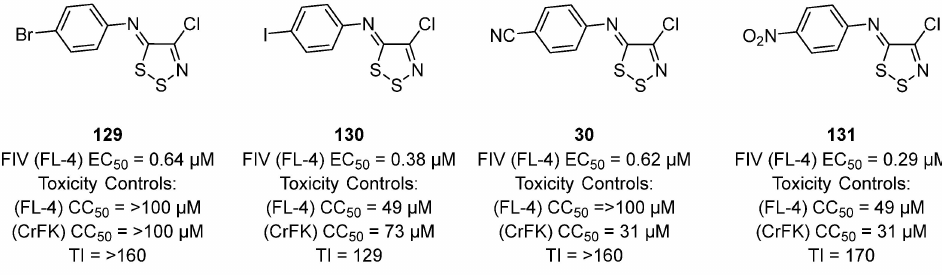
Figure 25. Initial hit compounds from the 1,2,3-dithiazole